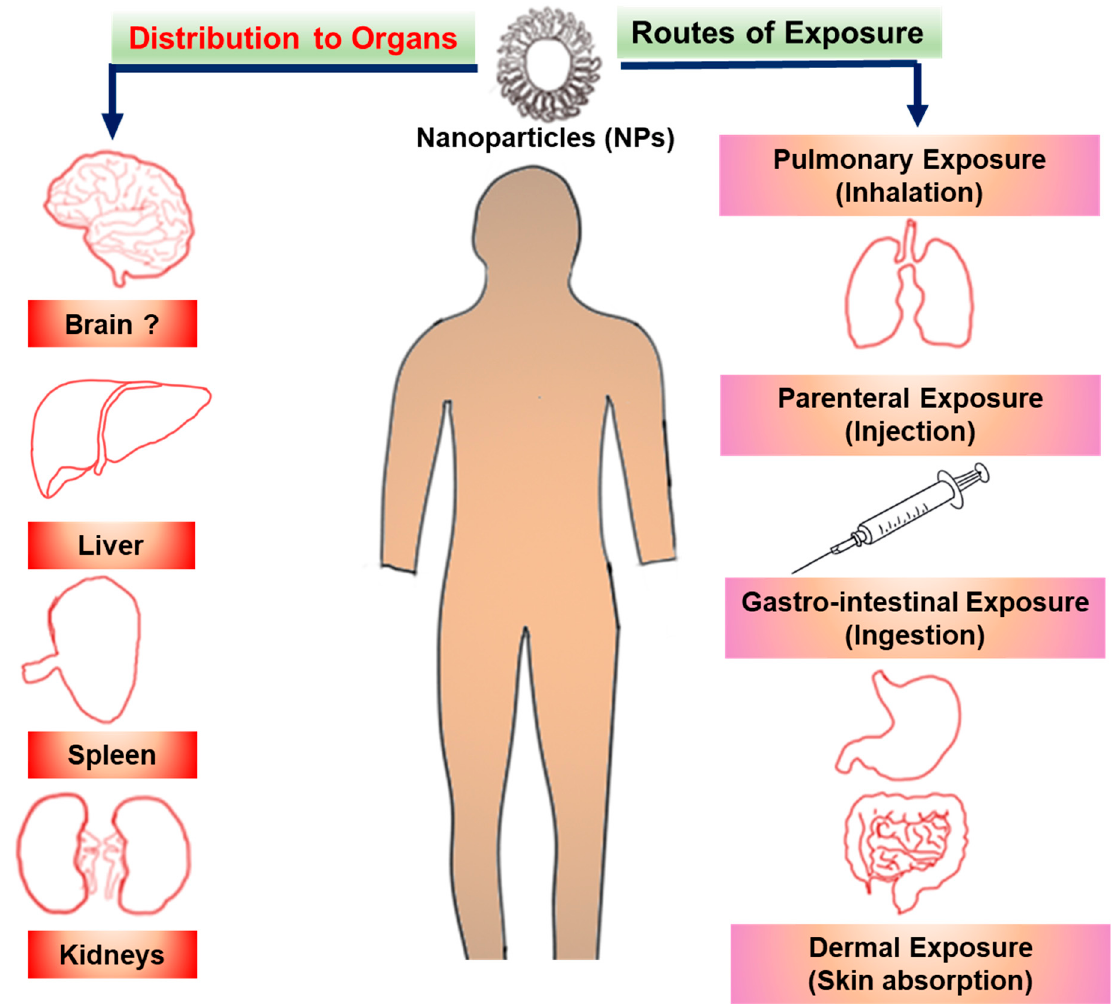
Figure 2. Routes of exposure to NPs and their distribution to organs in the human body. Exposure to NPs may be through lungs, injection, ingestion or skin absorption. Distribution organs include liver, spleen and kidney. The brain is suggested as a potential target for NP distribution, however direct evidence is still lacking.